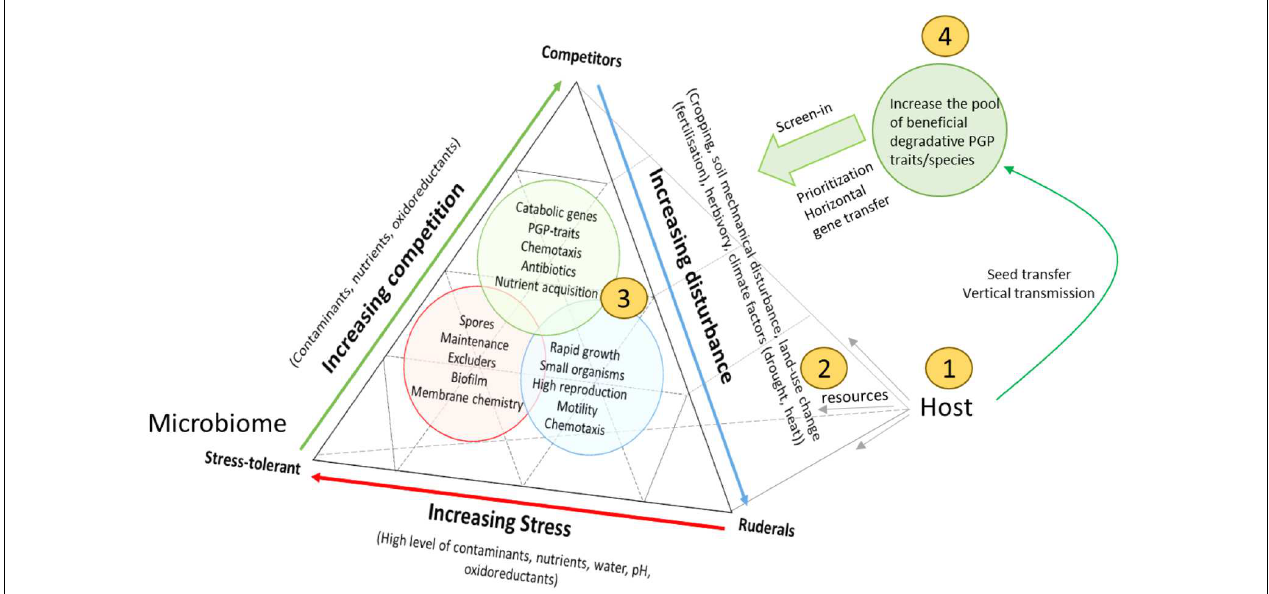
FIGURE 1 | Schematic representation of the different interactions taking place between the host and its rhizosphere microbiome, and possible ways to interfere with rhizosphere microbiome functioning for phytoremediation. The figure is adapted from Krause et al. (2014) who extended the competition-tolerant-ruderal life strategy of plants to microbial communities in soil. We add the plant-host to it, and use this framework for assigning life-strategies to rhizosphere microorganisms: (S) stress-tolerant, (C) competitors, (R) ruderals, and many intermediate microbial life strategies. It is assumed that the host fuels the interactions by providing abundant resources. S, C, or R can represent single species or functional groups of microorganisms (consortia), and the terms are used to distinguish S (contaminant-tolerant species), competitors (degradative competitors, exploitation competitors, or interference competitors), and ruderals (rapid growing species). Although the plant-provided resources (plant exudates) fuel higher growth rates of all microorganisms, some of the resources can be partitioned more to beneficial, degradative microorganisms that outcompete others (e.g., by capitalizing unique carbon sources, producing antibiotics, etc.). As such, it can be understood that degradative traits may be selected for by the host, if it confers a competitive superiority in the rhizosphere niche, meaning that biodegradation is ideally coupled to growth (central metabolism) and detoxification. If contaminant concentrations are low, plants may preferable recruit PGP, while commensals and pathogens capitalize on the resources. Which equilibrium is reached depends on which microbial type has the higher abundance and functional activities. Moreover, the community can also display priority effects: it is much more difficult for pathogens/opportunists to invade a community already dominated by primary colonizers (e.g., catabolic strains). Compared to an idealized model, the effectiveness of contaminant degradation may be limited by the presence of opportunists that do not contribute to biodegradation but consume the same resources, or detrimental strains that inhibit the activity of catabolic strains. Disturbing the communities in their niche, by selecting the host species (1), manipulation of their nutrients (root-exudates) (2) and corresponding niches (by disturbance) (3), or the introduction or removal of key members (4), may significantly alter the balance and strength of interactions between them. These interventions can cause changes in the way that microorganisms can influence each other, their niche, and the host, with consequences for phytoremediation